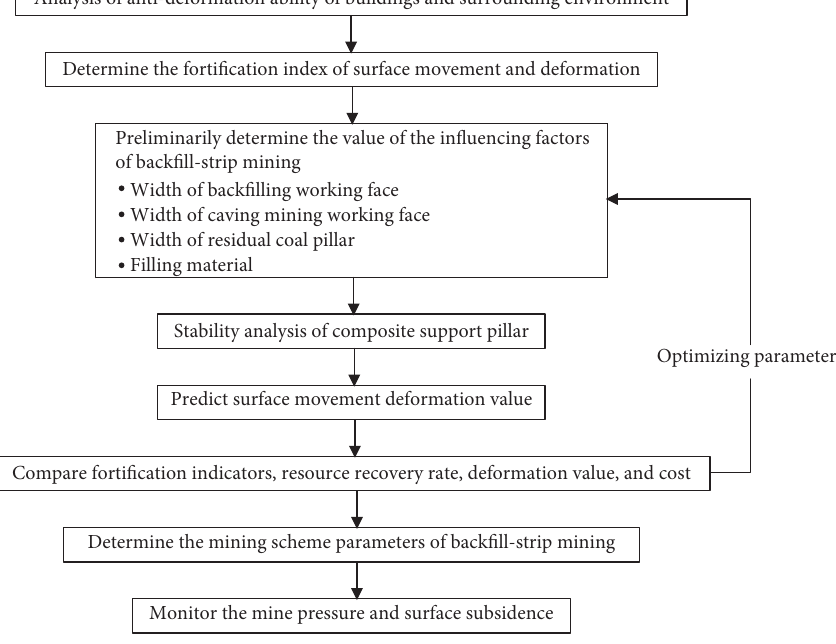
Figure 2: Subsidence control design flow of backfill-strip